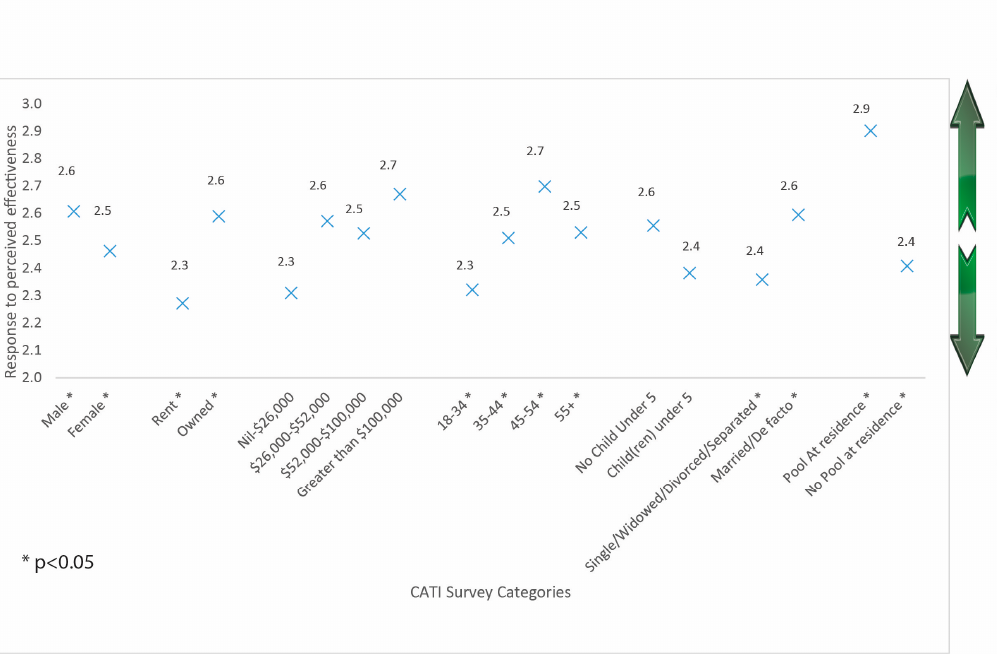
Figure 3. Perceived effectiveness of changes in Queensland to pool fencing legislation to achieve reduction in child drowning deaths by CATI survey categories.